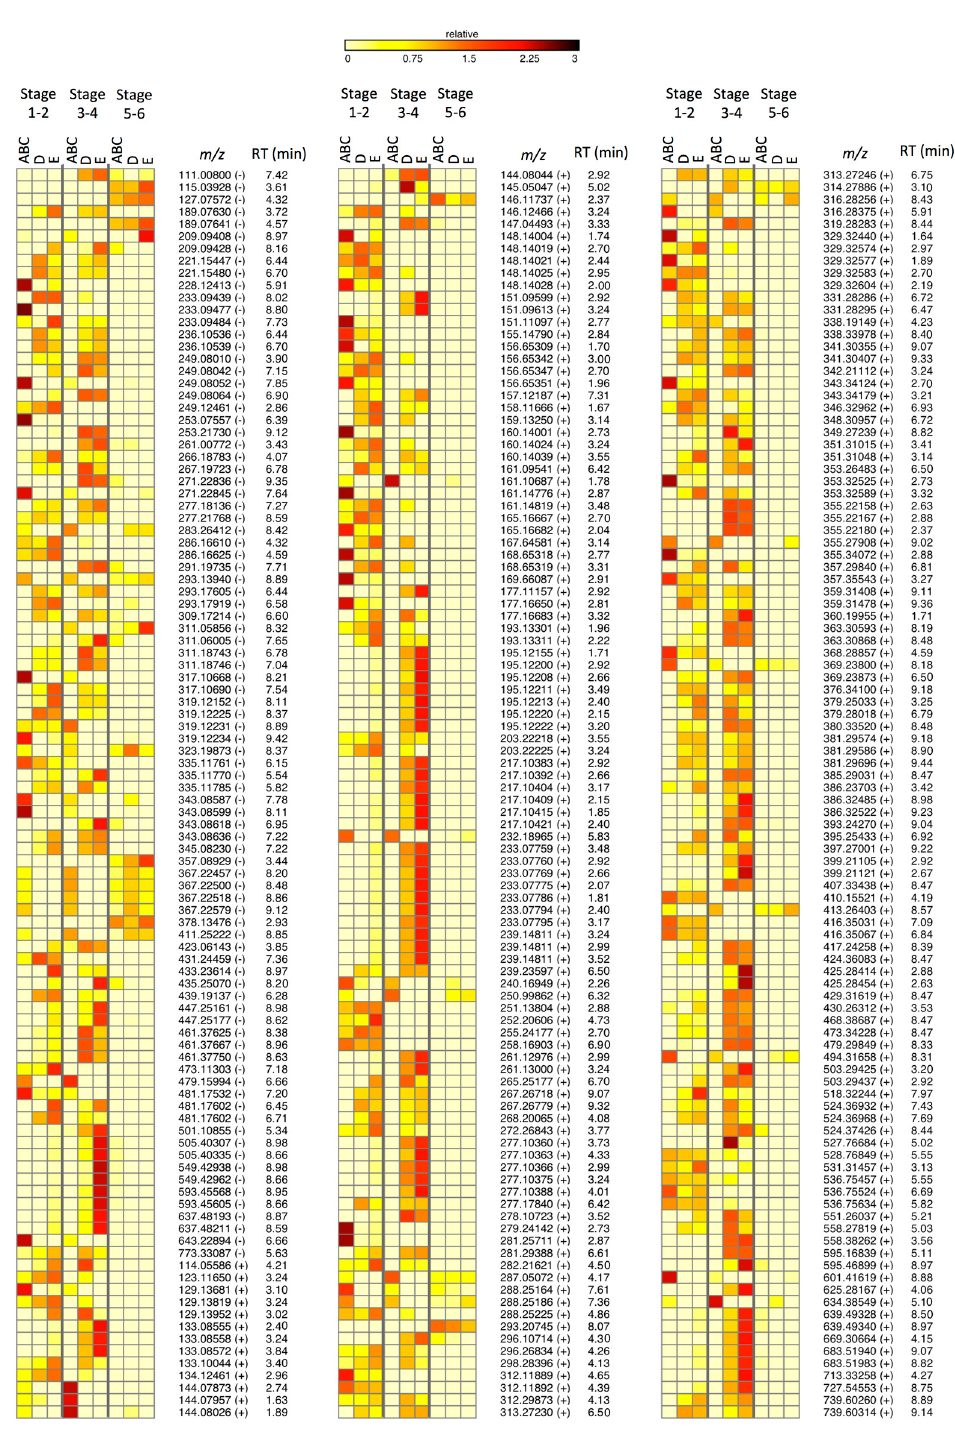
Figure 3. Heat map in which the relative abundances of metabolite ions, assigned a key role in the plant’s salinity response, are presented. The degree by which a metabolite’s concentration level changed, is thereby indicated by the color gradation rather than by the absolute color intensity. Each of the metabolites is characterized by a unique combination of retention time and m/z -value, whereby the ionization mode is indicated by the plus and minus sign. In order to simplify, it was opted to combine the results of specific EC-treatments and developmental